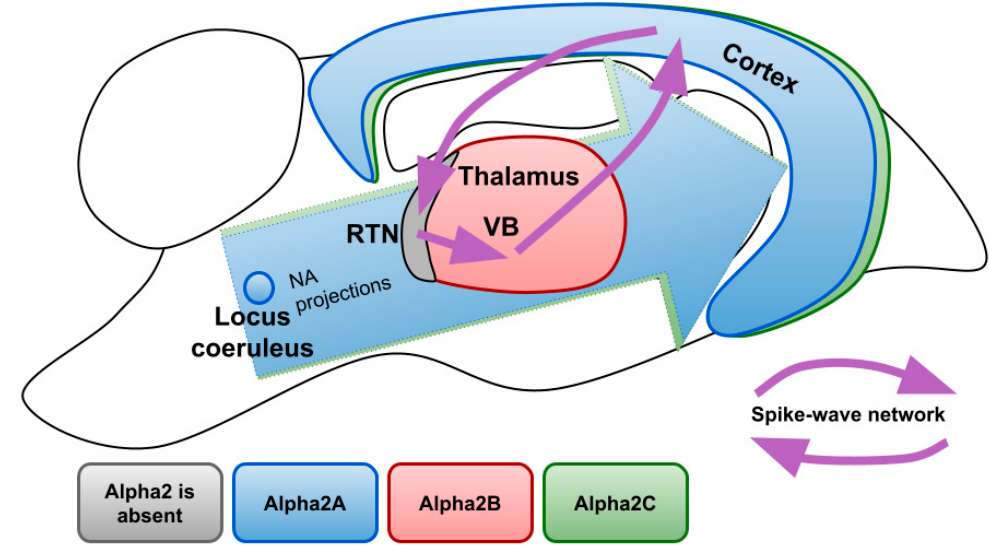
Figure 3. Expression profiles of different alpha2 AR subtypes over the brain structures involved in the generation of SWDs. NA—noradrenaline; RTN—reticular nucleus; VB—ventrobasal thalamus.